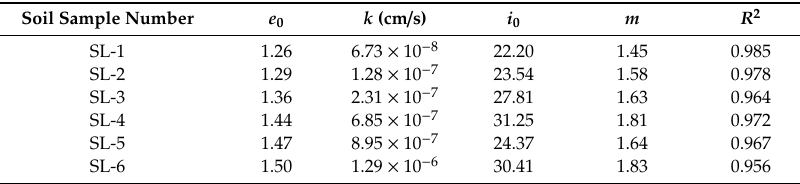
Figure 3. Comparison of experimental results and those obtained from Hansbo’s flow fitting. Table 2. Hansbo’s flow fitting